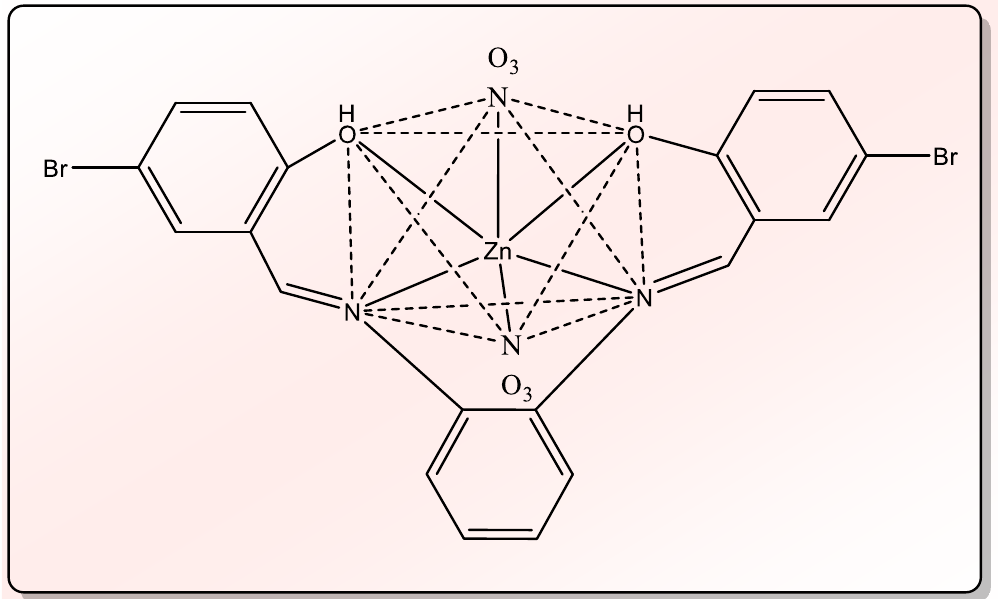
Figure 4. Suggested structure of Zn nano complex.